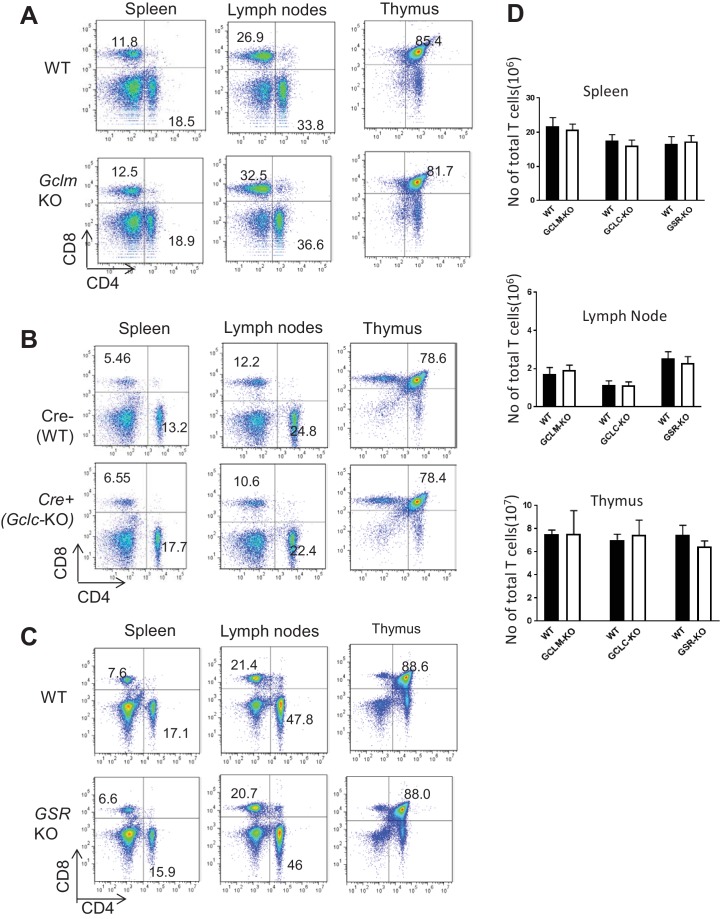
Severe depletion of GSH by blocking de novo synthesis suppresses T cell activation and proliferation.(A–C) Distribution of CD4+ and CD8+ cells in the spleen, lymph nodes or thymus from mice with indicated genotypes were determined by FACS. Figure 2A -D are representative of two independent experiments (D) Bar graph represents the number of T cells calculated from total splenocytes, lymph node cells and thymocytes.10.7554/eLife.36158.008Figure 2—figure supplement 1—source data 1.Source data for A, B, C and D.